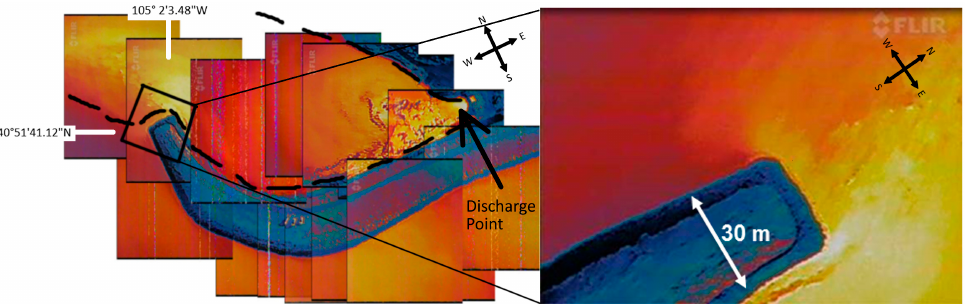
Figure 5. ( Left ) Composite image of the water surface showing thermal discharge from the Rawhide Energy Station obtained by the UAS IR camera. The location of the discharge point is indicated while the approximate plume contour is shown with a dashed line; ( Right ) Single image of a thermal plume at the end of the discharge guide berm.